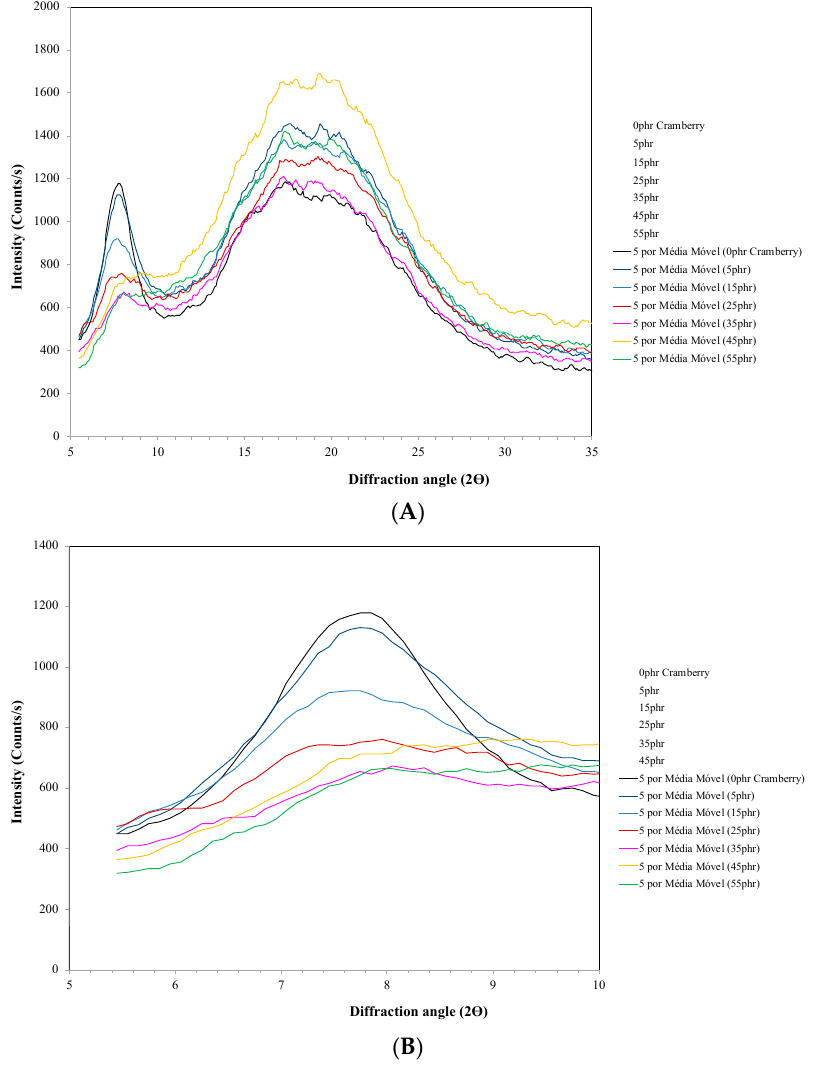
Figure 2. X-ray diffraction of arrowroot starch and gelatin films incorporated with cranberry, 0, 5, 15, 25, 35, 45 and 55%: ( A ) X-axis scale from 5 to 35; ( B ) X-axis scale from 5 to 10°.